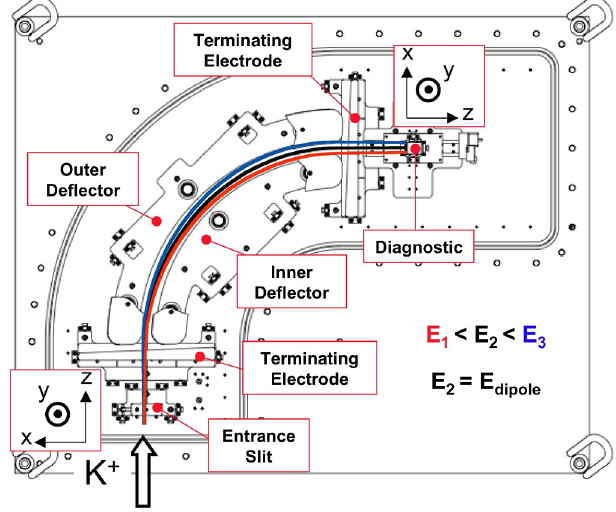
FIG. 4. Schematic of the ion trajectories though the spectrome- , blue) are shown ter. Ions with energy greater than the dipole ( E 3 with a larger radius of curvature and ions with energy less than , red) are shown with a smaller radius of curvature. the dipole ( E 1 The coordinate system is shown at the entrance and exit of